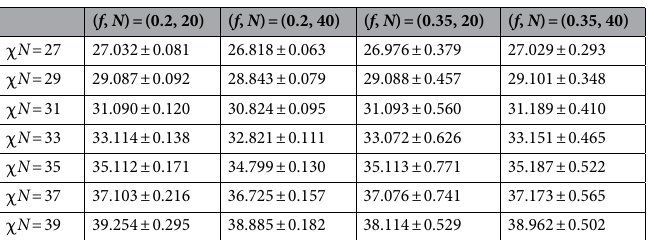
Table 5. Averages and standard deviations of estimated χ N values for each unlearned χ N